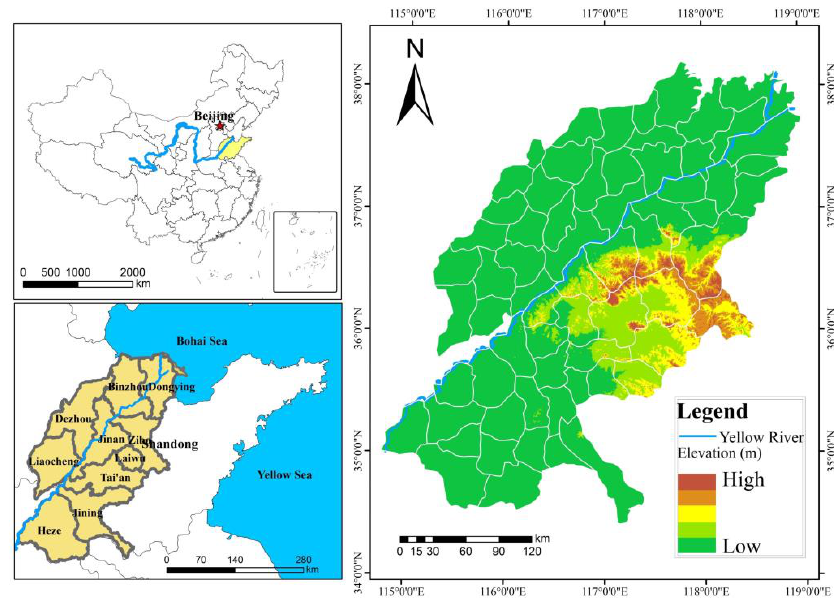
Figure 1. Location and elevation of the study